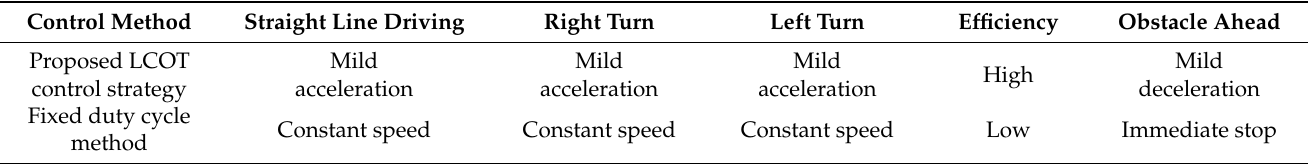
Table 3. Characteristics comparison of the two